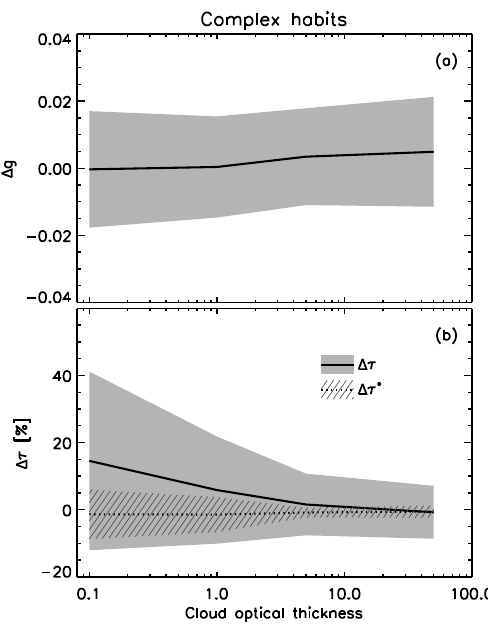
Fig. 7. Mean biases (solid lines) and standard deviations (shaded areas) of retrieved asymmetry parameters (a) , optical thickness (b) as a function of cloud optical thickness assumed in the simulated data using complex habits. The dotted line and line-shaded area in (b) shows the mean bias and standard deviation, respectively, of the scaled optical thickness.